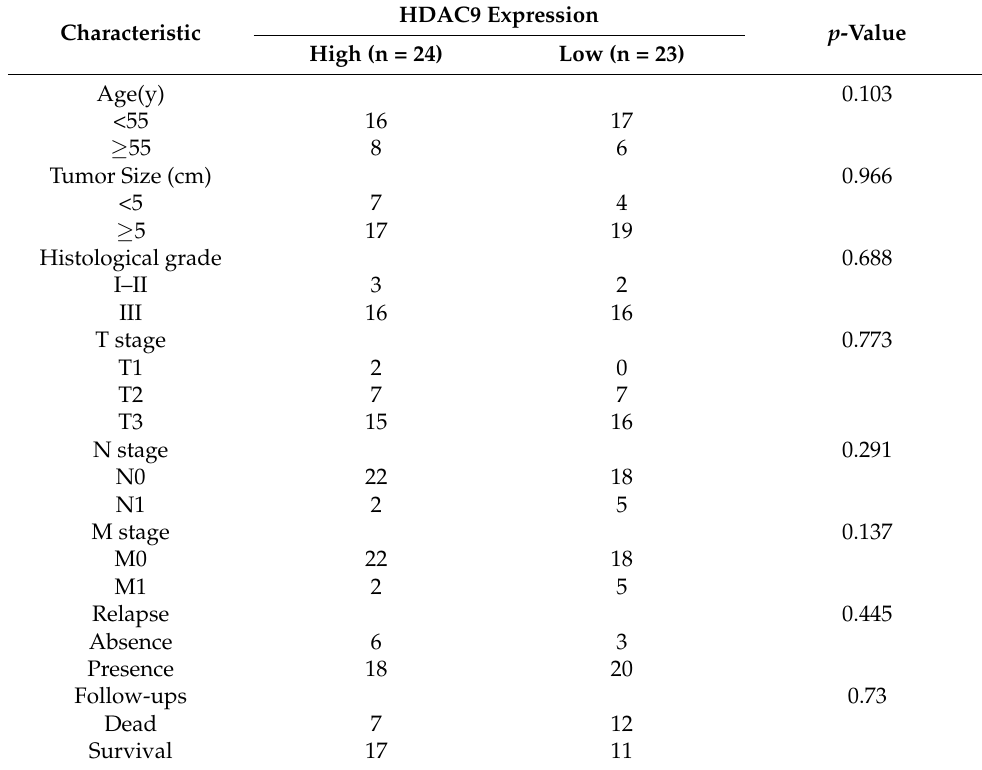
Table 2. Clinical pathological characteristics of non-serous ovarian cancer